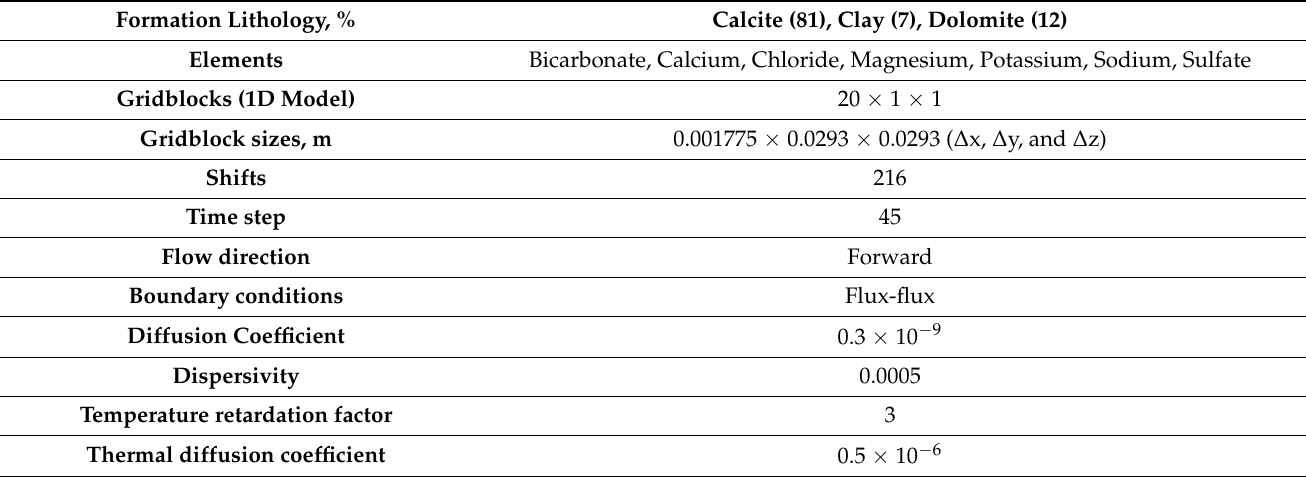
Table 6. Details of formation lithology, various elements, and gridblock dimensions.